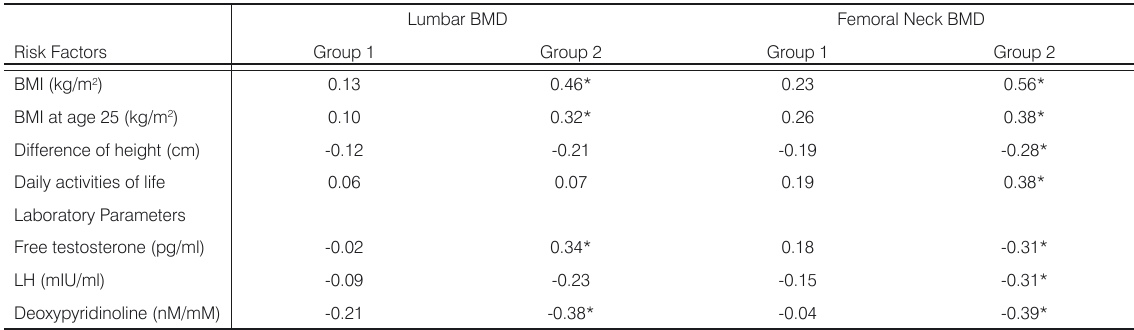
Table 3. Correlation of lumbar and femoral neck BMD with risk factors and laboratory parameters in Group 1 (<60 years) and Group 2 ( ≥ 60